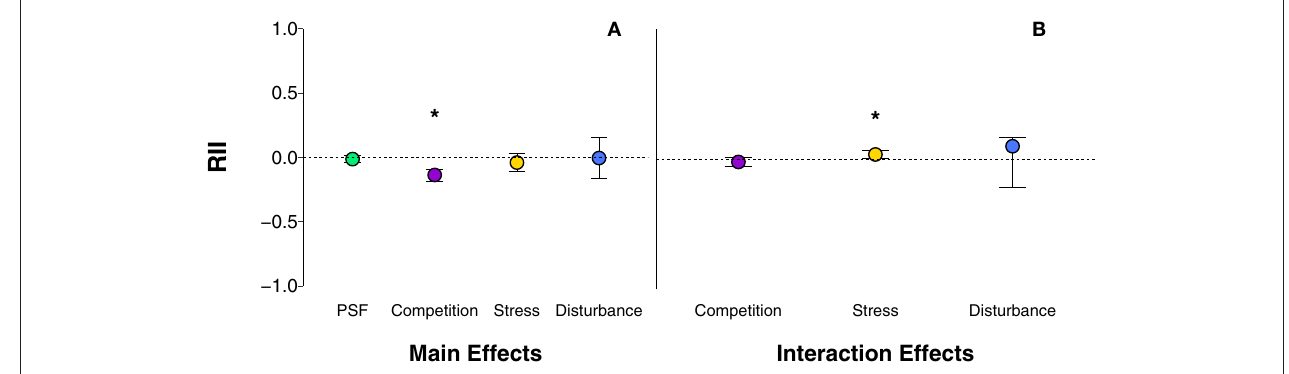
( Figure 2B ; p 0.12; Table S2 , row 196), grazing/herbivory = ( Figure 2B ; p 0.18; Table S2 , row 197), shade ( Figure 2B ; = p 0.63; Table S2 , row 198), mining ( Figure 2B ; p = Table S2 , row 199), and temperature